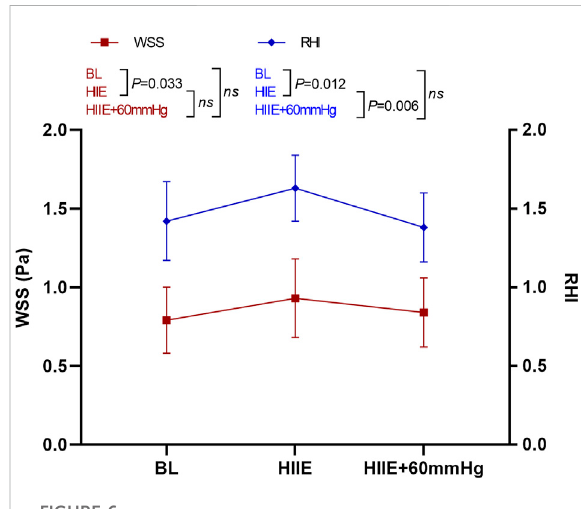
FIGURE 6 Changes in RHI and WSS at baseline and after HIIE and HIIE with 60 mmHg in fl ation. Note: RHI, reactive hyperemia index; WSS, wall shear